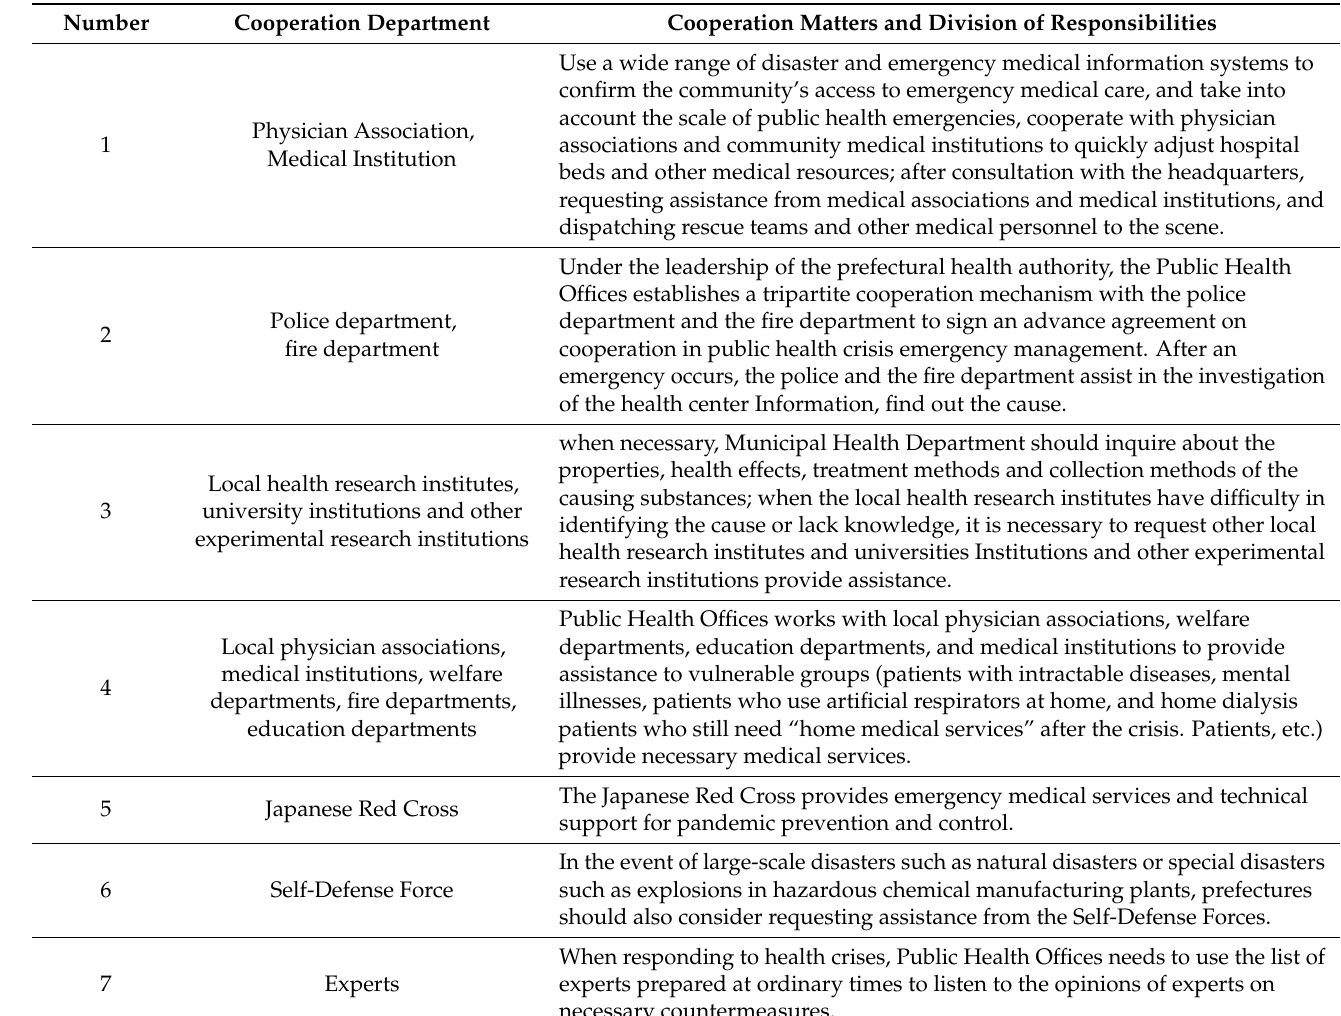
Table 1. Inter-departmental cooperation and division of responsibilities during public health emergency management.